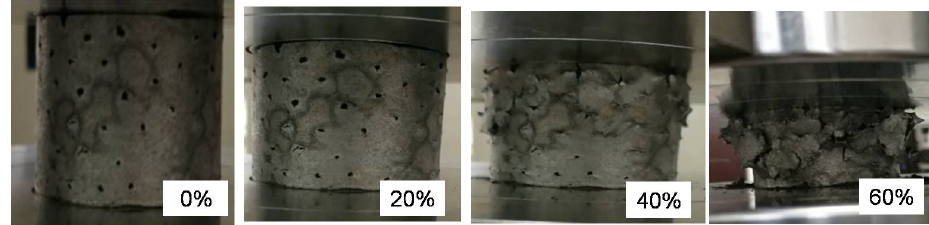
Figure 9. Compression of ASF-II showing different stages of compression: 0%, 20%, 40%, and 60% strain.